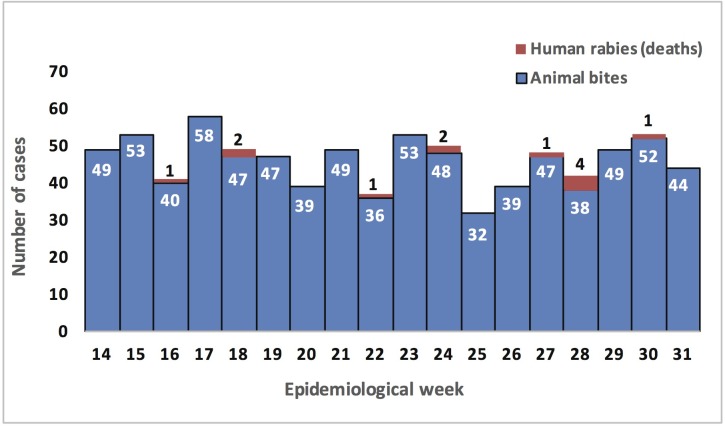
Frequency of cases of animal bite and rabies deaths in Maputo city and Province, April to July 2014.